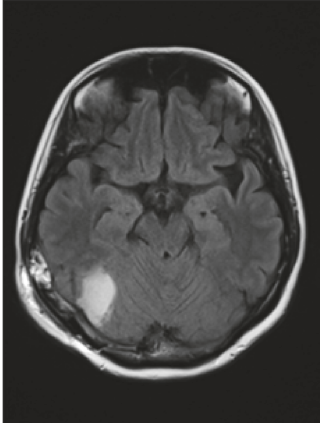
Figure 3: FLAIR MRI of the brain following resection. The menin- gioma was clearly resected, which resolved brain compression.